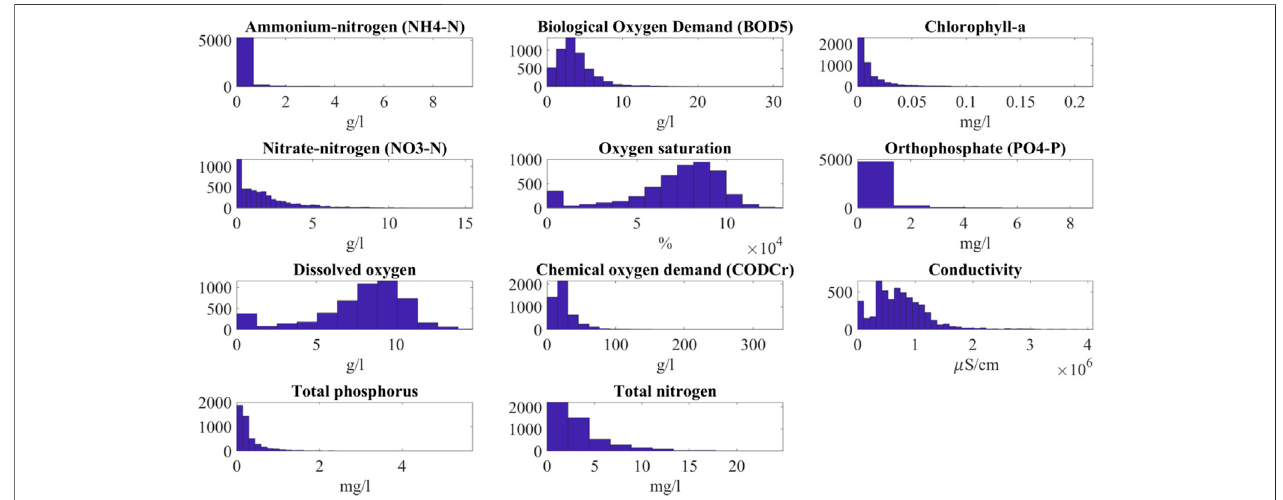
FIGURE 5 | The distribution of the water quality parameters in the Hungarian surface water